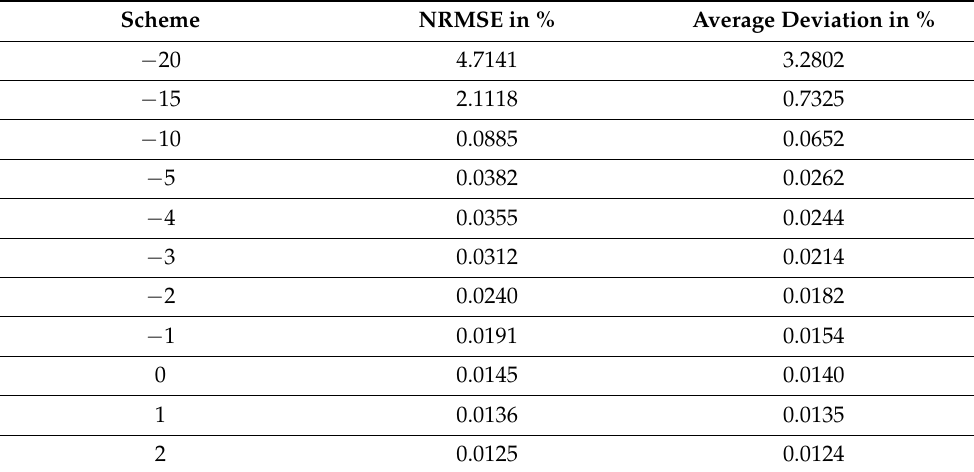
Figure 9. ( a ) NRMSE of methods under different SNR; ( b ) Average deviation of methods under different SNR. Table 1. NRMSE and average deviation of the cross-correlation spectrum method.